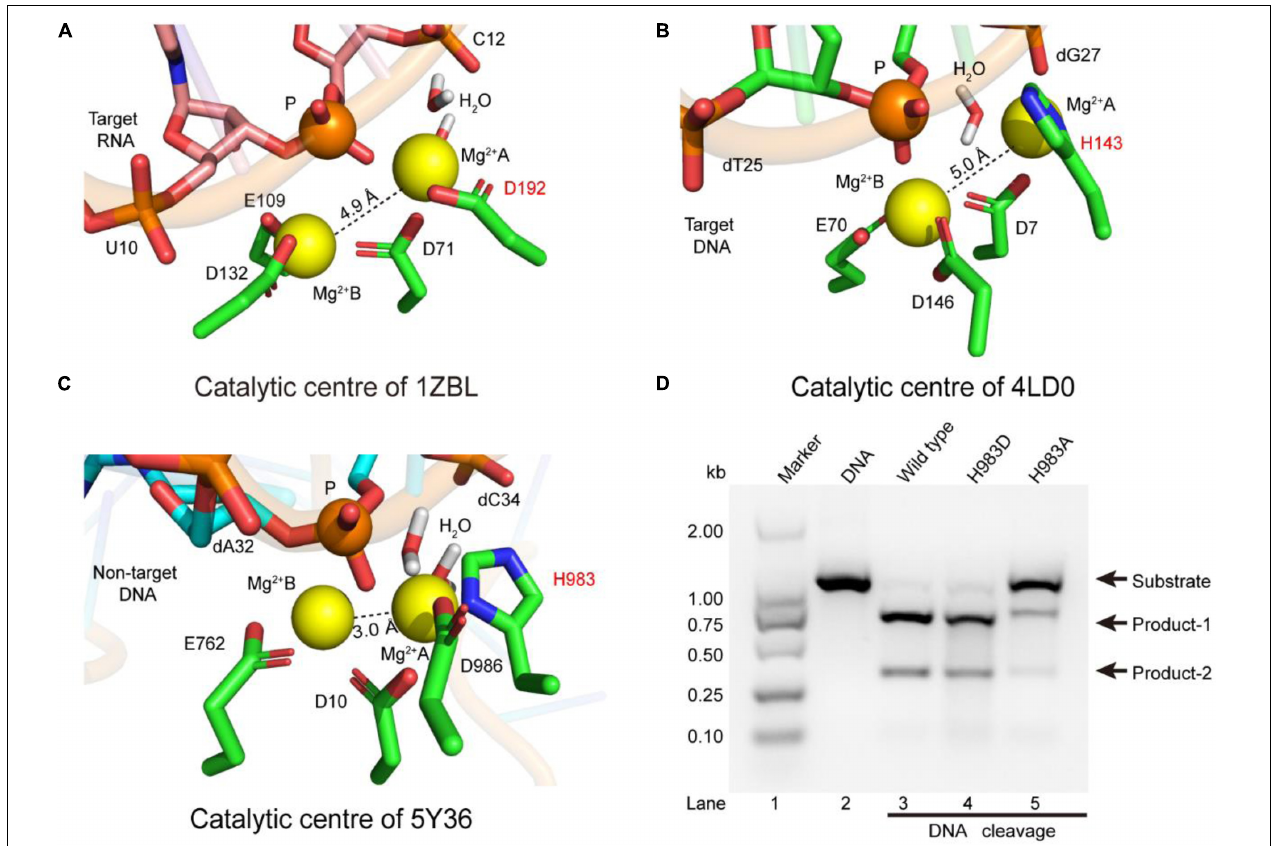
FIGURE 2 | The coordination configurations of the catalytic centers. (A–C) The stereoviews of the two-metal catalytic centers in the atomic models (PDB IDs: 1ZBL, 4LD0, and 5Y36, respectively). The Mg 2 + ions are coordinated by the ligands (amino acids, phosphate groups, and water molecules). (D) In vitro cleavage activities of SpCas9 and its mutants. The target DNA molecules are cleaved into two products (product-1 and -2).